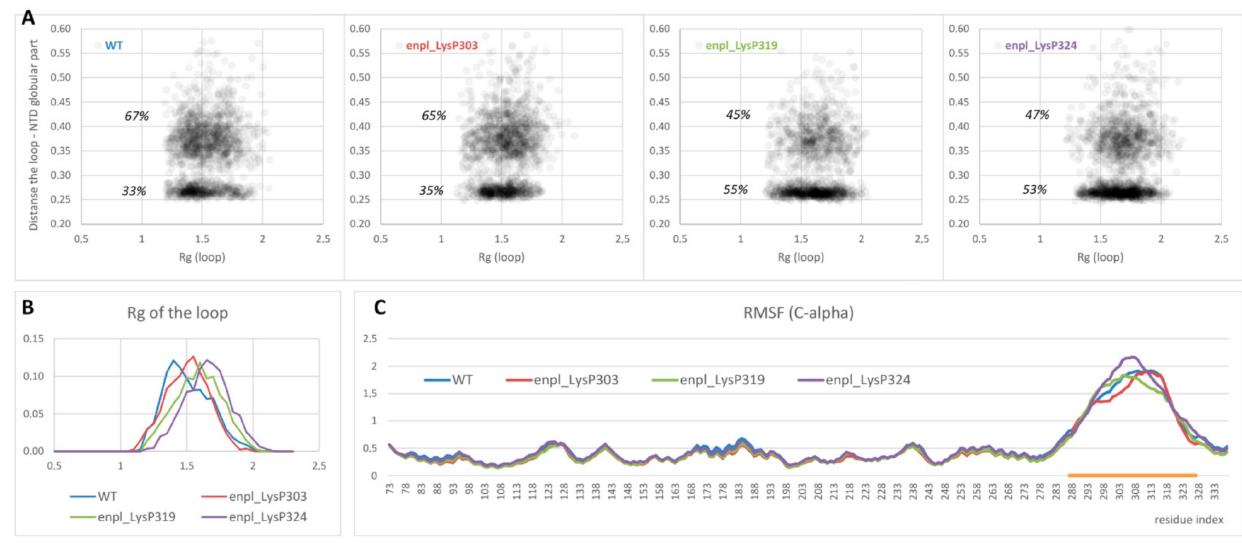
Figure 5. ( A ) Distribution of conformations in the space (R g of the disordered loop; minimum distance between the loop and globular part of the N-terminal domain) obtained from REMD ensemble. ( B , C ) R g distribution ( B ) as well as RMSF profiles of C-alpha atoms ( C ) for the same systems. The region of the loop is highlighted with